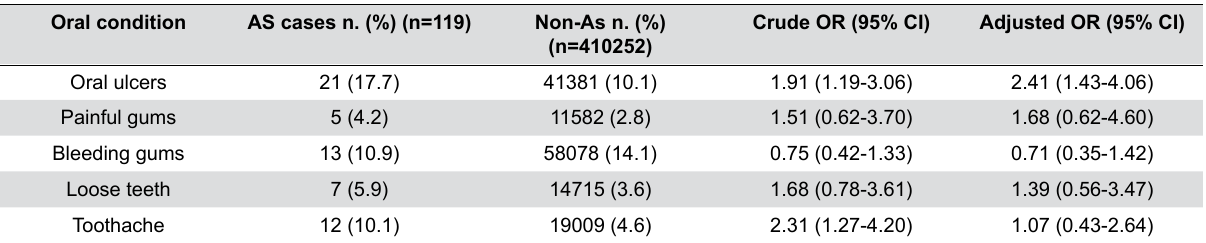
OR=Odds ratio, CI=Confidence interval, Adjusted OR=Adjusted for age, gender, education level, smoking status, alcohol frequency intake, and body mass